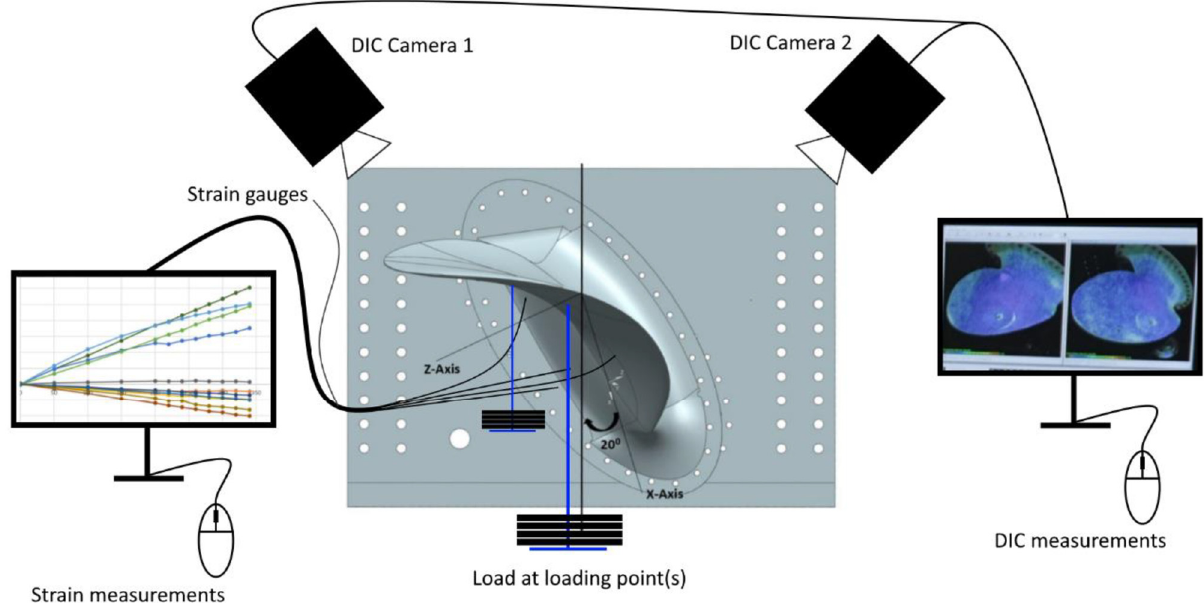
Figure 10. Schematic of experiment design. The propeller blade is incrementally loaded while strain and digital image correlation (DIC) measurements are logged.